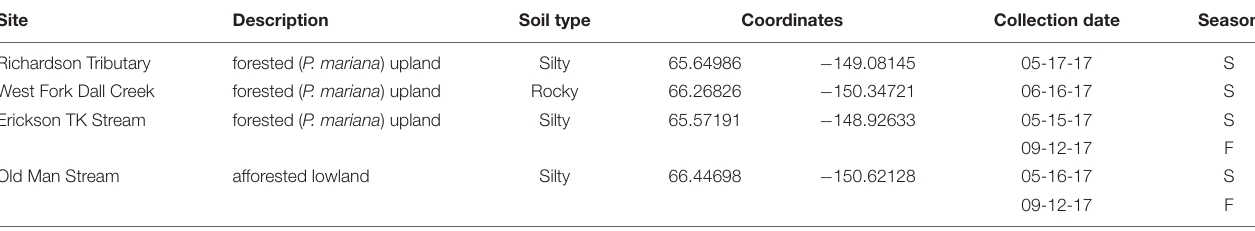
TABLE 1 | Site information for stream sampling in the Yukon Flats, Interior Alaska.